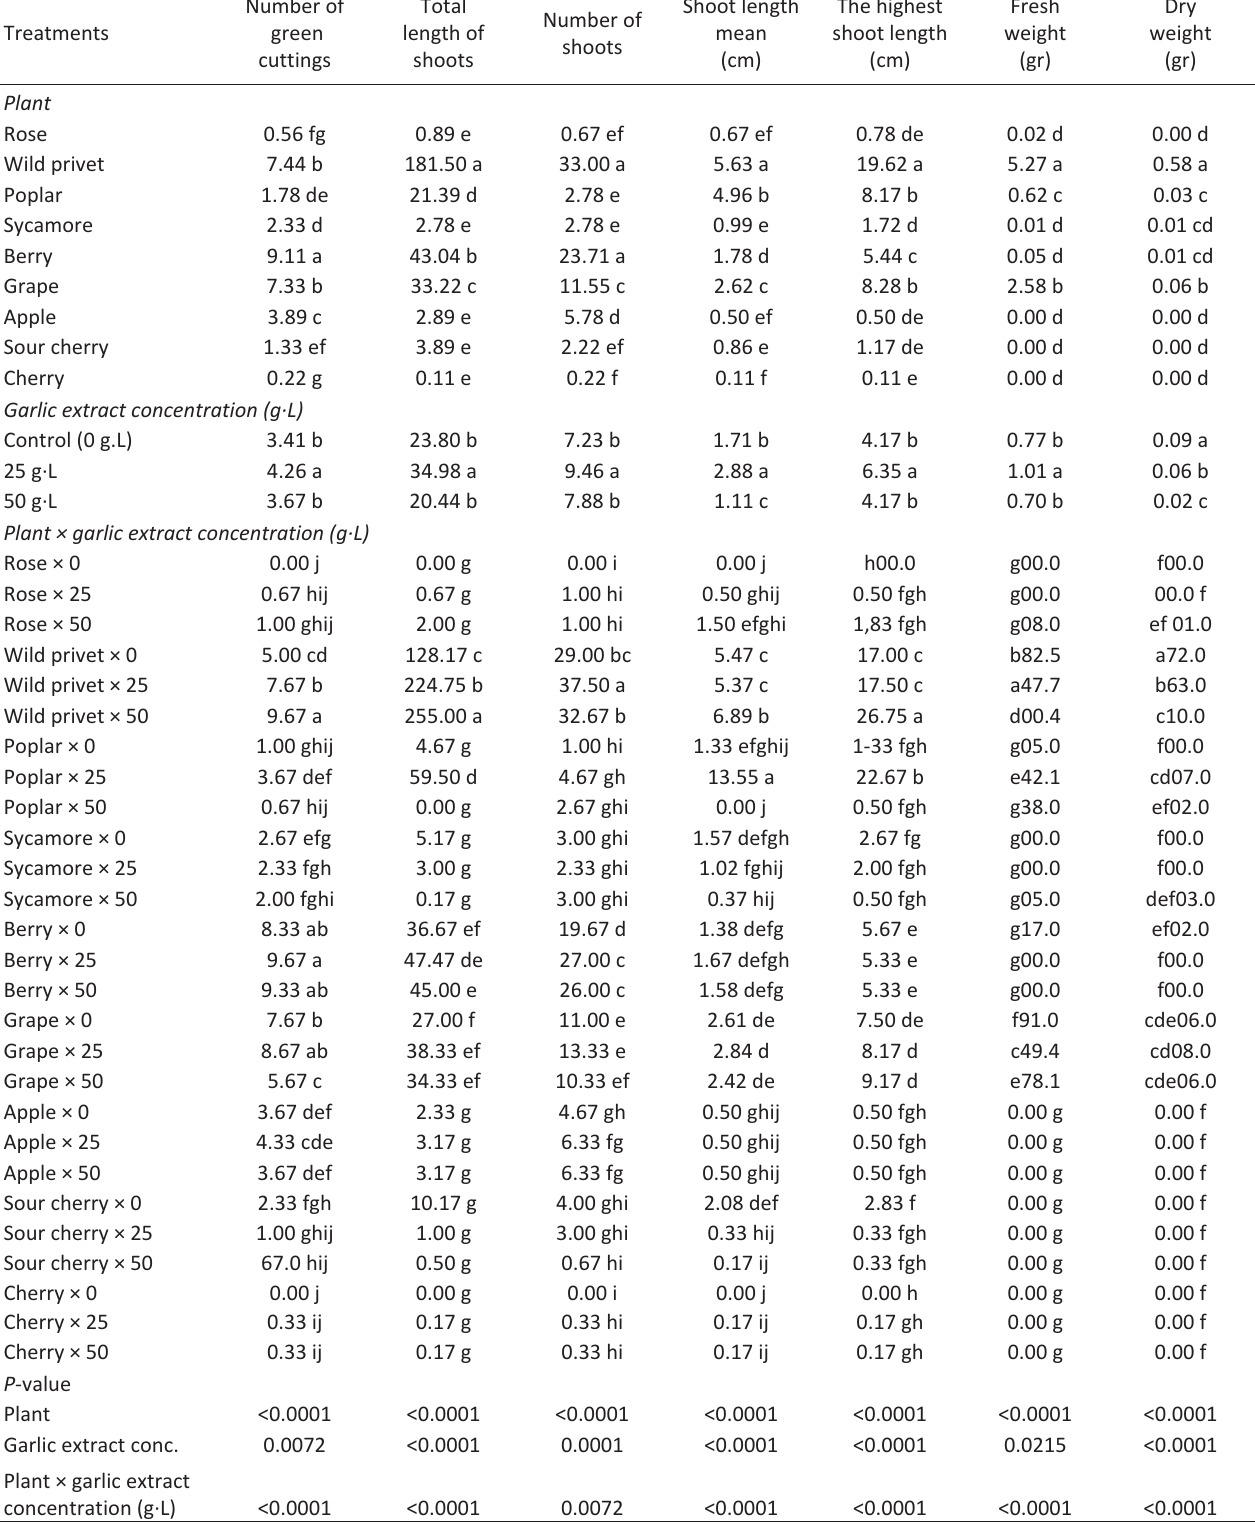
Mean values followed by the similar letters within a column are not significantly different from each other at P ≤0.05 (Duncan’s multiple range